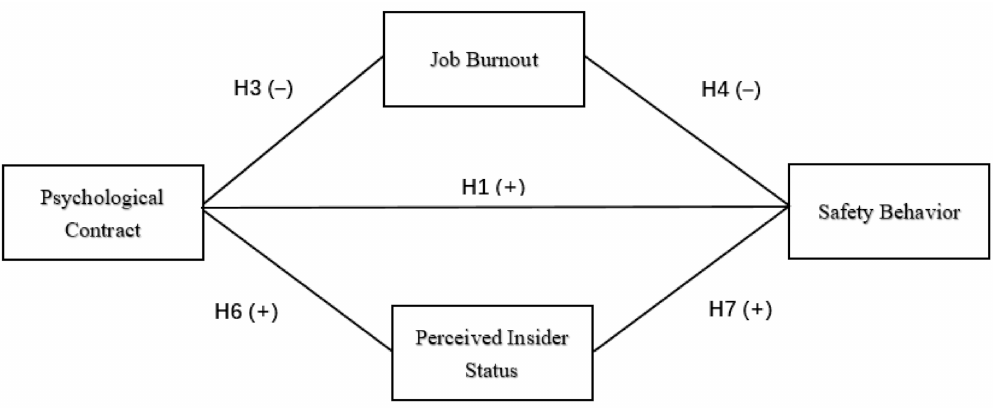
Figure 1. Conceptual